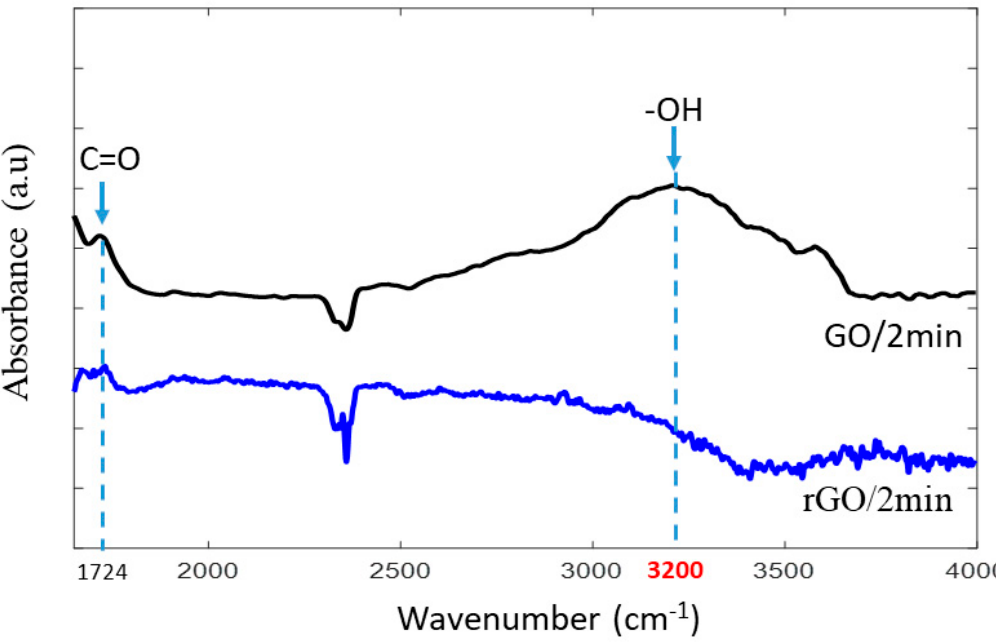
Figure 7. FTIR spectra of GO-2min PT-PES and rGO-2min PT-PES membranes.